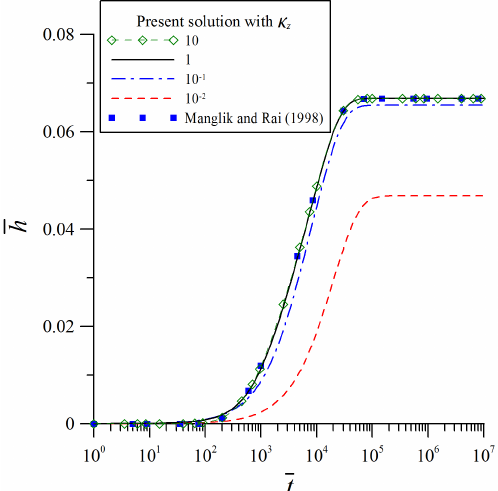
Figure 3. Temporal distributions of the dimensionless head pre- dicted by the Manglik and Rai (1998) solution based on 2-D flow and the present solution for 3-D flow with various κ z